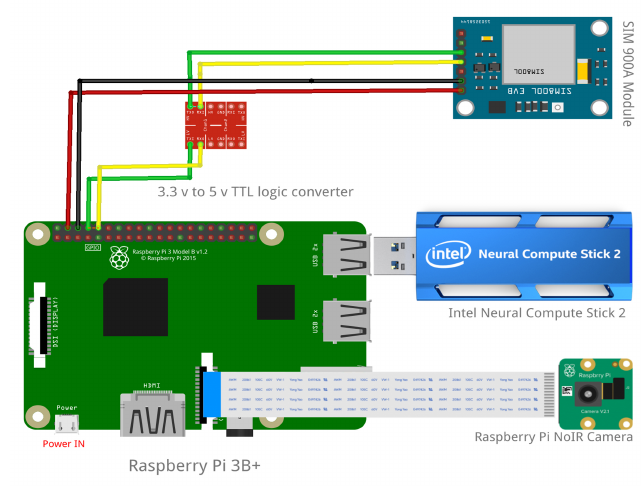
Figure 5. Circuit diagram of the design.